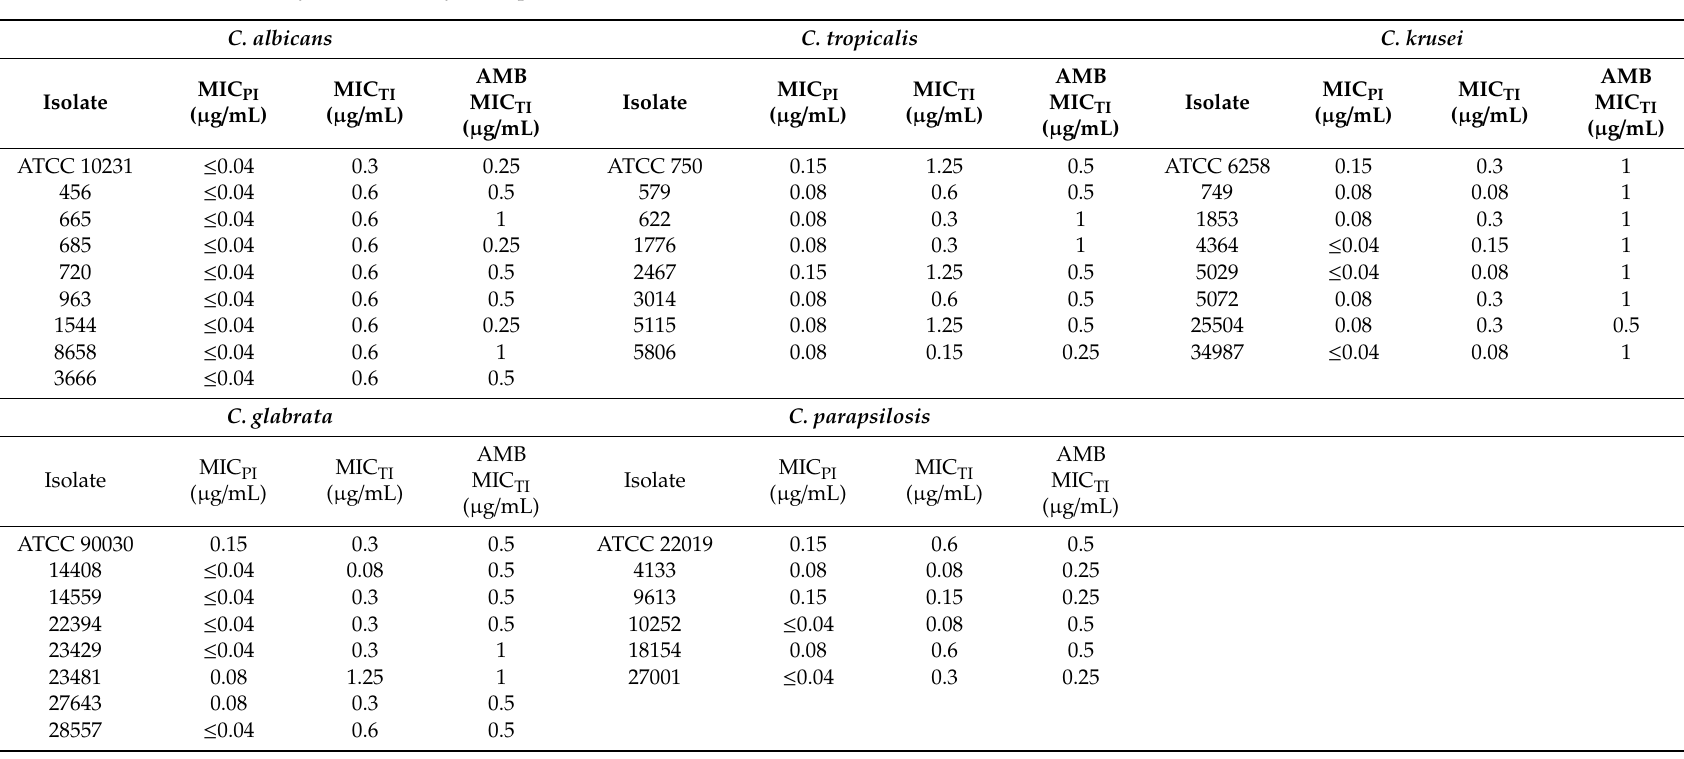
Table 2. In vitro susceptibilities of Candida isolates to DIMICAN and amphotericin B (AMB), determined by CLSI broth microdilution method. MICs were determined according to the CLSI M27-A3 using the partial (MIC PI ) and total inhibition (MIC TI ) criteria. [22]. MICs were read visually after 48 h incubation at 35 ◦ C using the partial (50%) inhibition (for DIMICAN) (PI) and total inhibition (for AMB and DIMICAN) (TI) criteria. MICs were determined at least twice. DIMICAN = 1,1- N